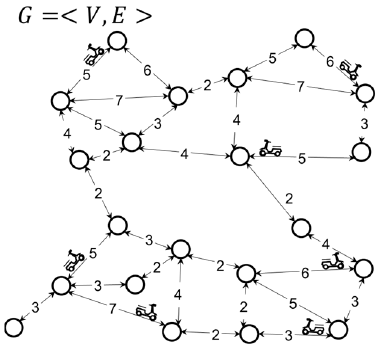
Figure 2. Diagram of road network.